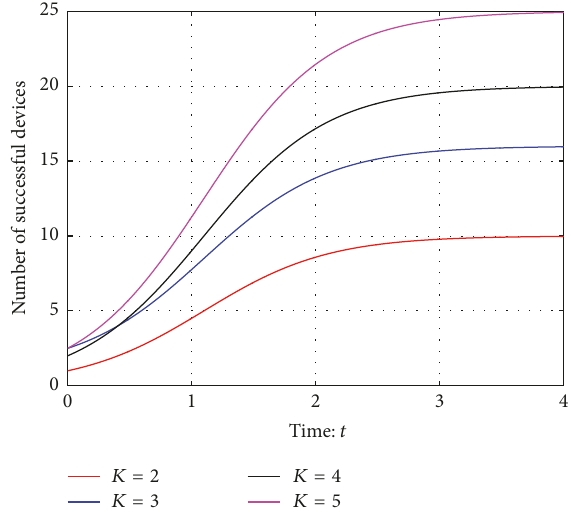
Figure 5: Influence of the generation size 𝐾